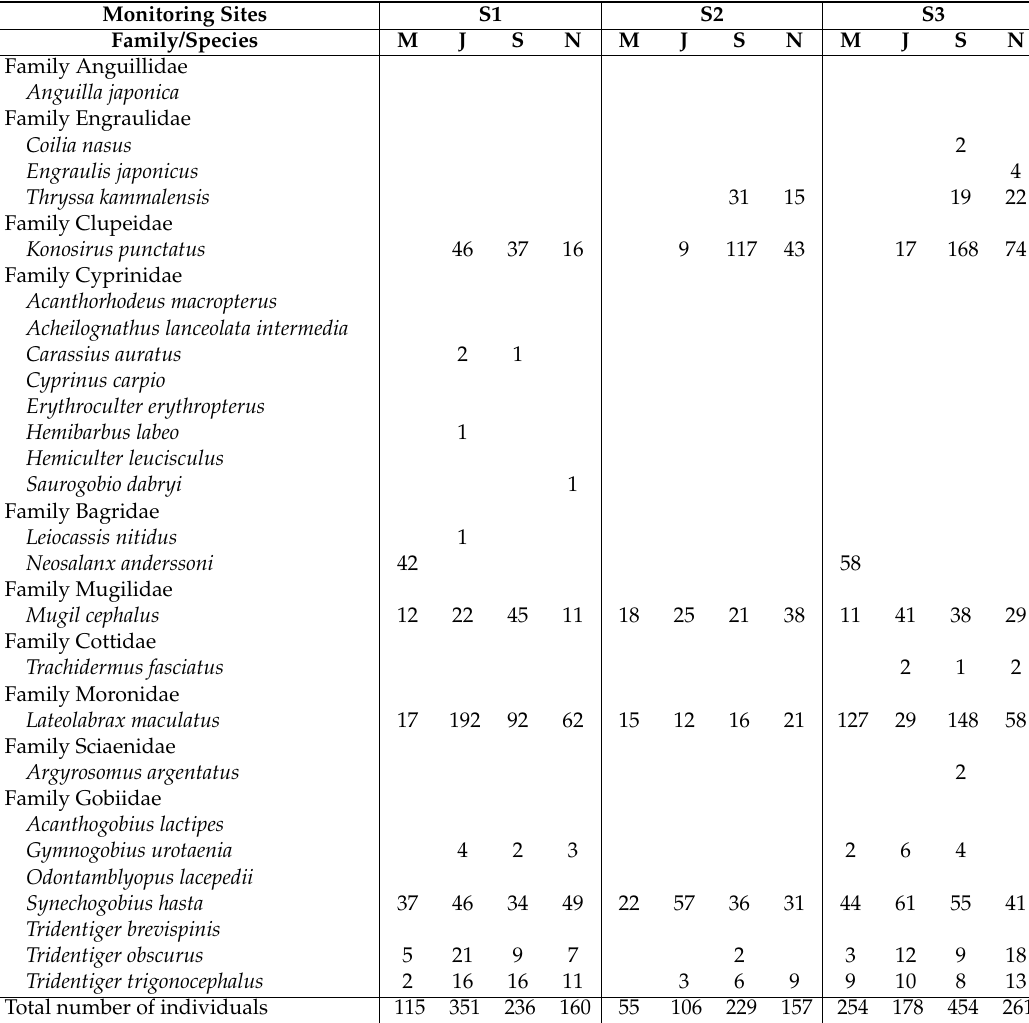
Table A1. Results of freshwater, brackish, and saltwater fish survey in 2014. Fish were caught using both catching nets (mesh size: 5 mm × 5 mm) and kick nets (mesh size: 4 mm × 4 mm), and the catch per unit effort (CPUE) method was adopted for quantitative collection. Gill nets (mesh size: 25 mm × 25 mm, length: 25 m) were also installed for the investigation. (M: March, J: June, S: September, N: